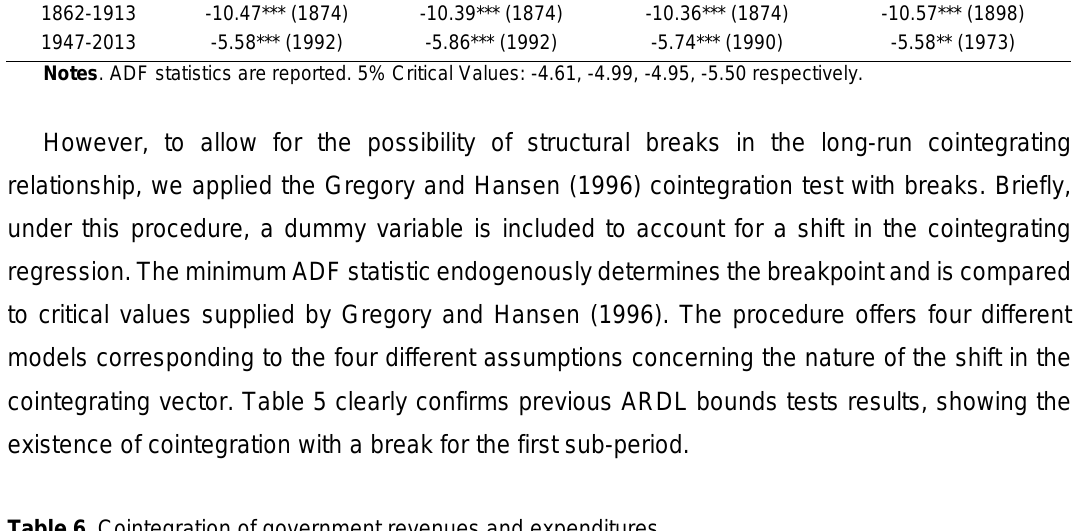
Table 6 . Cointegration of government revenues and